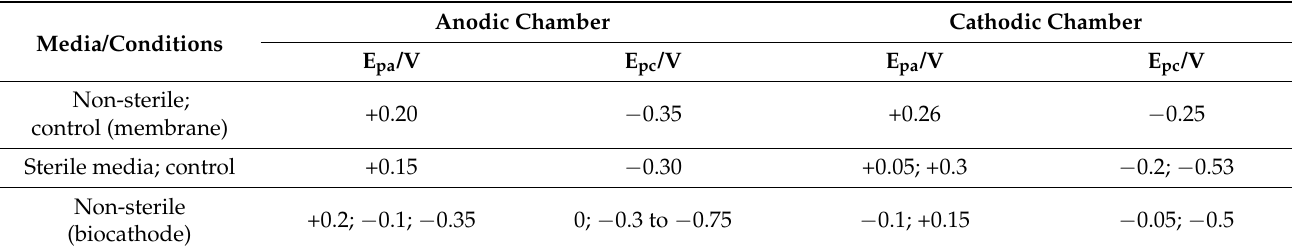
Table 1. Redox processes potential values attained for sterile (abiotic cathode), non-sterile (biocathode) and control (w/membrane) conditions in the in situ electrochemical assays.